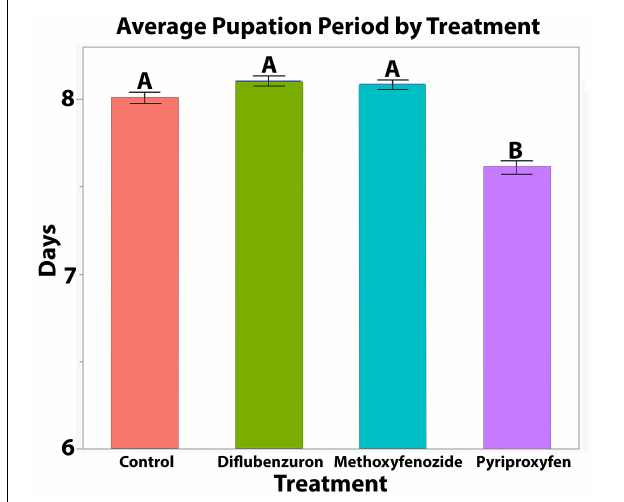
FIGURE 2 | Average ± S.E. time from first observation of successful pupal eclosion to successful adult eclosion of Apis mellifera workers following developmental exposure to IGDs. Significance indicated by letters (LMM, Tukey HSD, See Table 1 ).